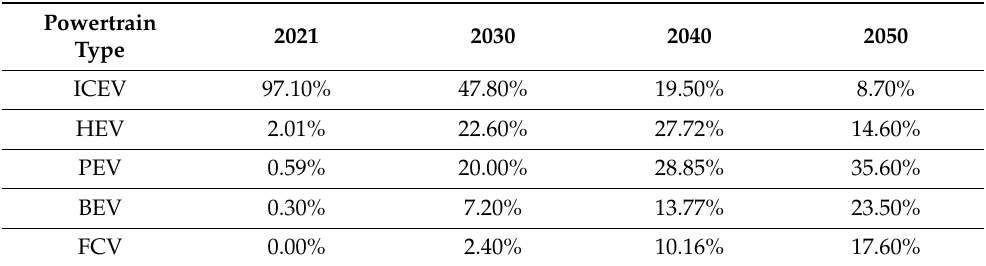
Table 5. Current and upcoming percentage deployment of passenger vehicles by powertrain/fuel type in Italy (own analysis from